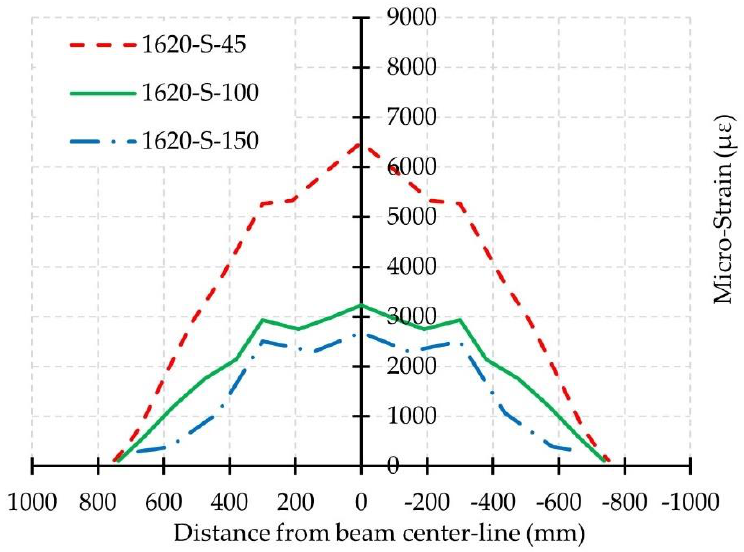
Figure 24. Strain distribution along the HFRP strips of 1620-S-45, 1620-S-100 and 1620-S-150 at 380 kN.